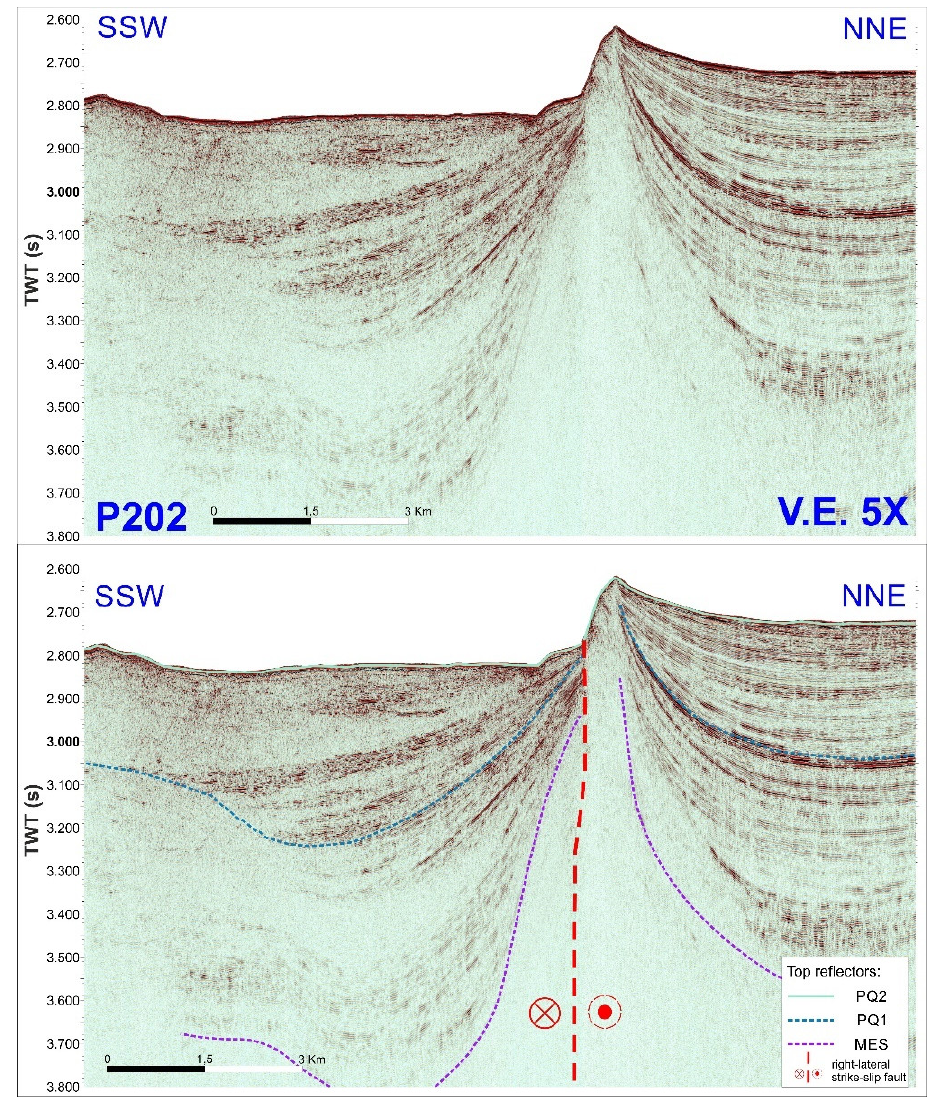
Figure 10. The p202 seismic profile and its interpretation below (see location in Figure 5).